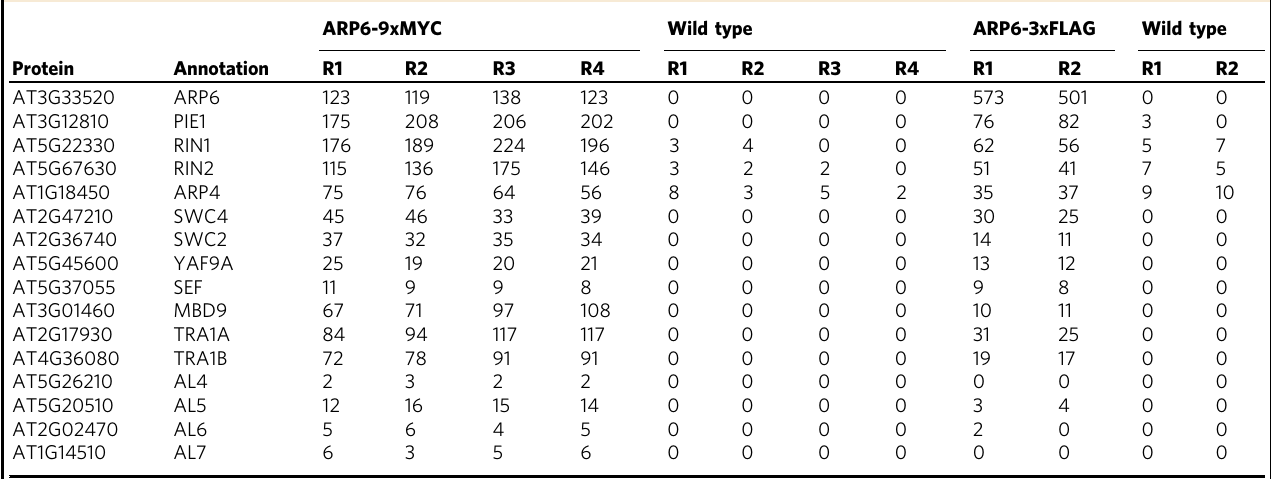
Table 1 IP – mass spectrometry of